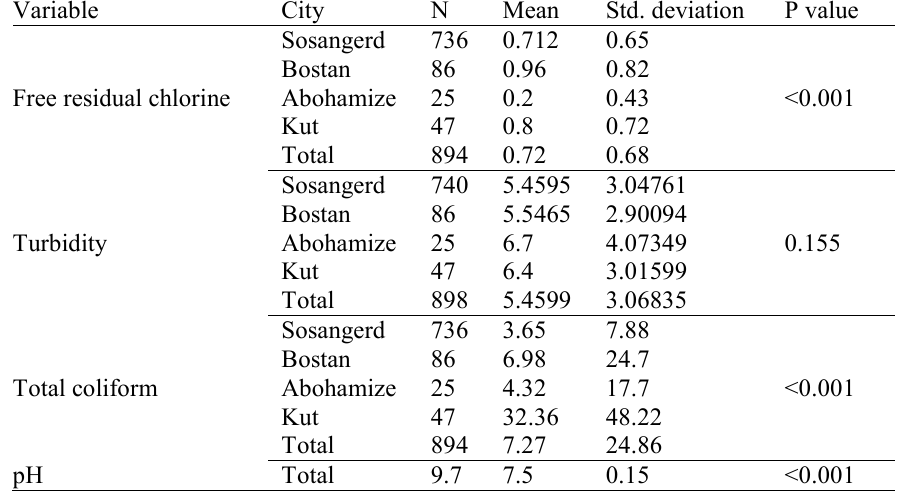
Table 2. Descriptive statistics on residual chlorine and turbidity in various cities Variable